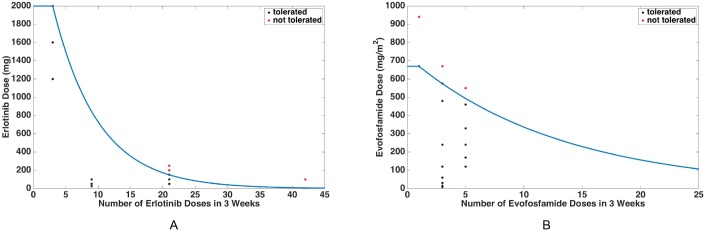
Toxicity constraint curves for erlotinib and evofosfamide.These curves depict the maximum tolerated doses of erlotinib (A) and evofosfamide (B) as functions of frequency of dose administration. The black points are the coordinates from Table 2 corresponding to tolerated dosing schedules, and the red points are the ordered pairs in Table 2 associated to dosing schedules that were not tolerated in clinical trials. All points contained in the areas on and below these two curves make up the space of tolerated monotherapy dosing schedules, and all points contained in the areas above these two curves make up the space of dosing schedules which lead to dose-limiting toxicities. The curves themselves represent the space of all monotherapy maximum tolerated dosing schedules.